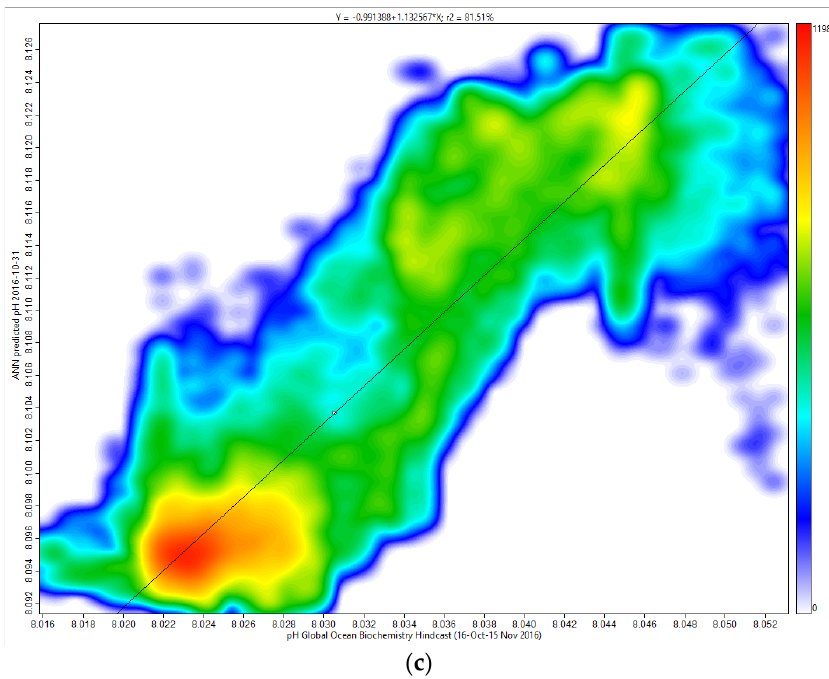
Figure 9. pH distribution map ( a ) ANN-estimated pH valid for 30 October 2016; ( b ) extracted from the Global Ocean Biochemistry Hindcast valid for 16 October–15 November 2016, and ( c ) scatterplot between ( a ) and ( b ) (R 2 = 0.81).